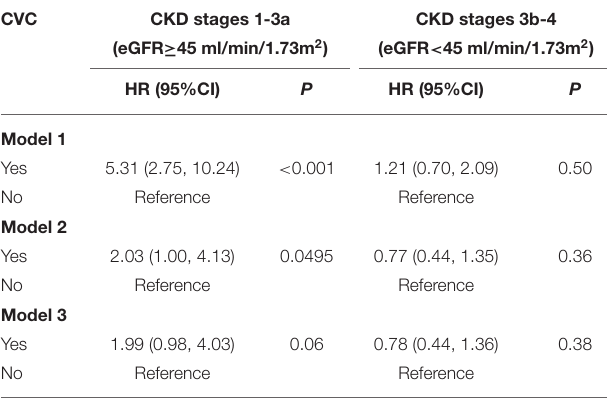
association in the CKD stages 1-3a group kept three decimal places in order to show statistical